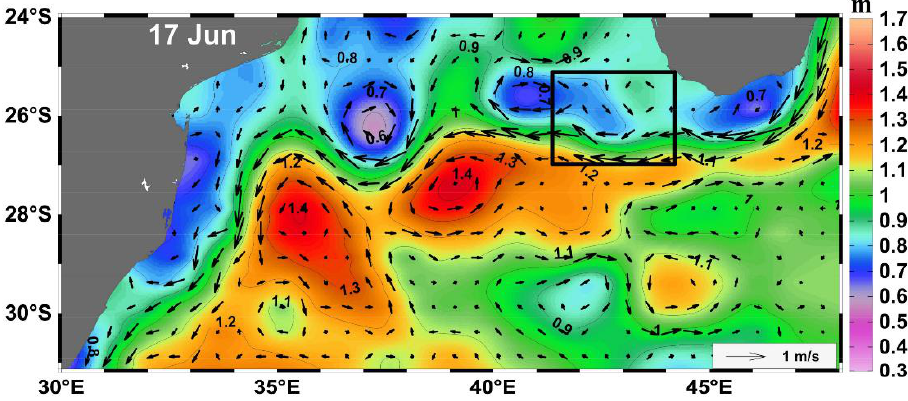
Figure 3. Sea Surface Height (colour contours) and geostrophic velocity (black arrows) over the Mozambique Basin on 17 June 2013. The black box highlights the location of the cyclonic eddy.